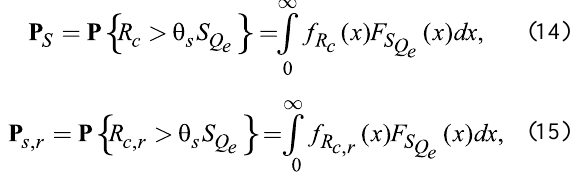
Fig. 3. Models for structural safety analysis of load-carrying members by the Hall (1998) (a) and the present author’s (b, c)